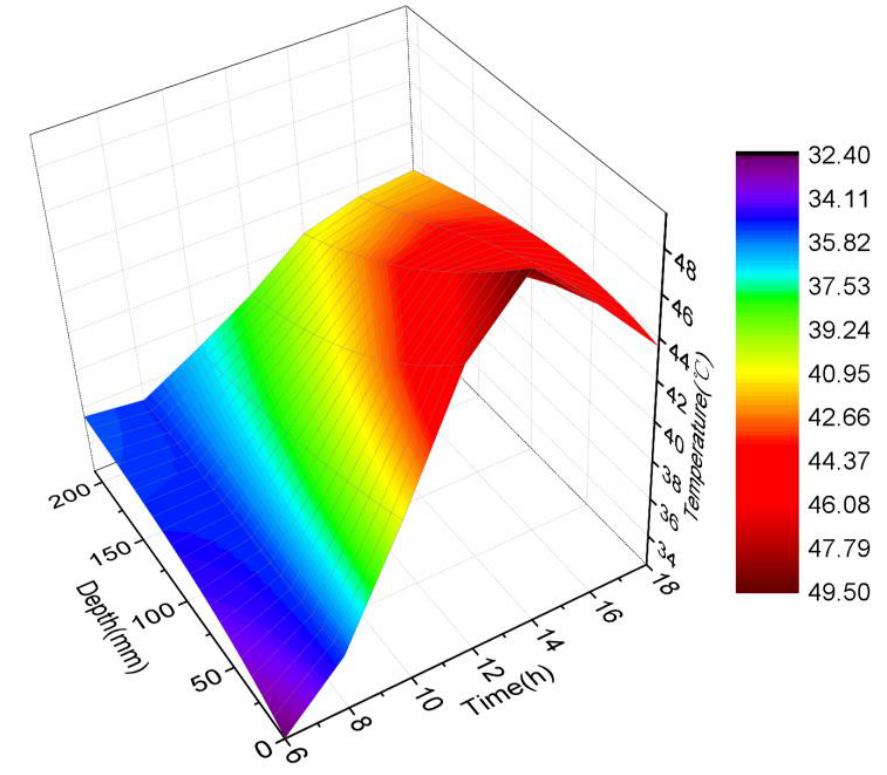
Figure 4. Diagram of simulation results of temperature variation with time at different depths during the daytime.